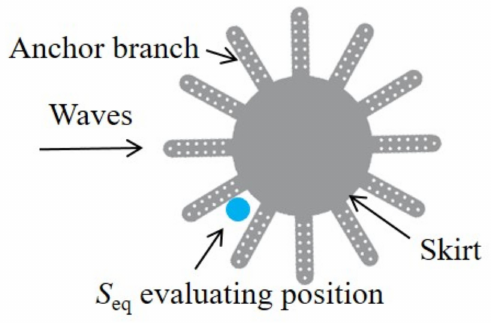
Figure 14. Sketch of the position where the S eq was evaluated.